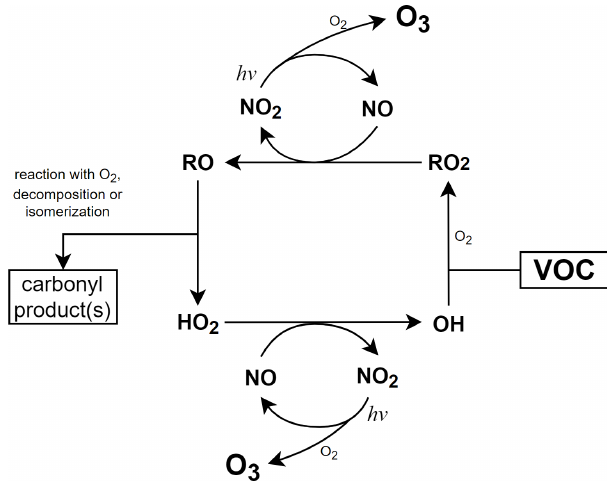
Figure 1. The photochemical formation of O 3 in the presence of NO x and VOCs (Jenkin and Hayman,